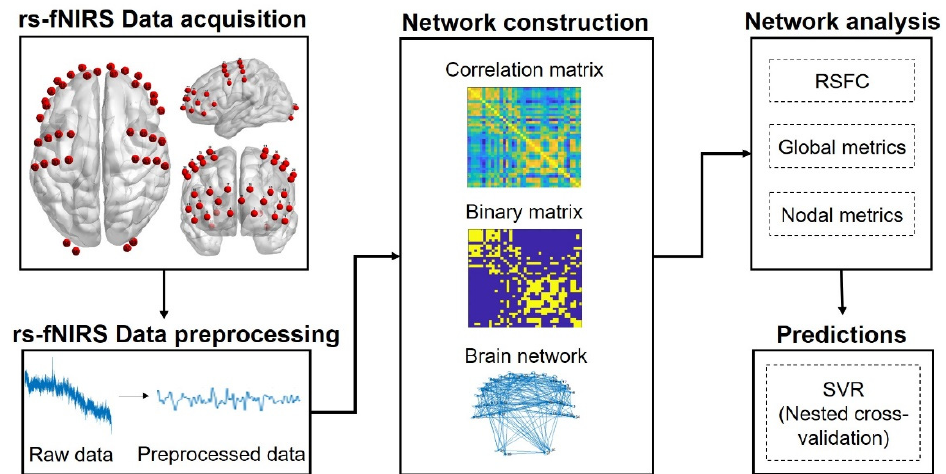
Figure 1. Overview of resting-state functional near-infrared spectroscopy (rs-fNIRS) channel locations and analytical pipeline. RSFC, resting-state functional connectivity. SVR, support vector regression.